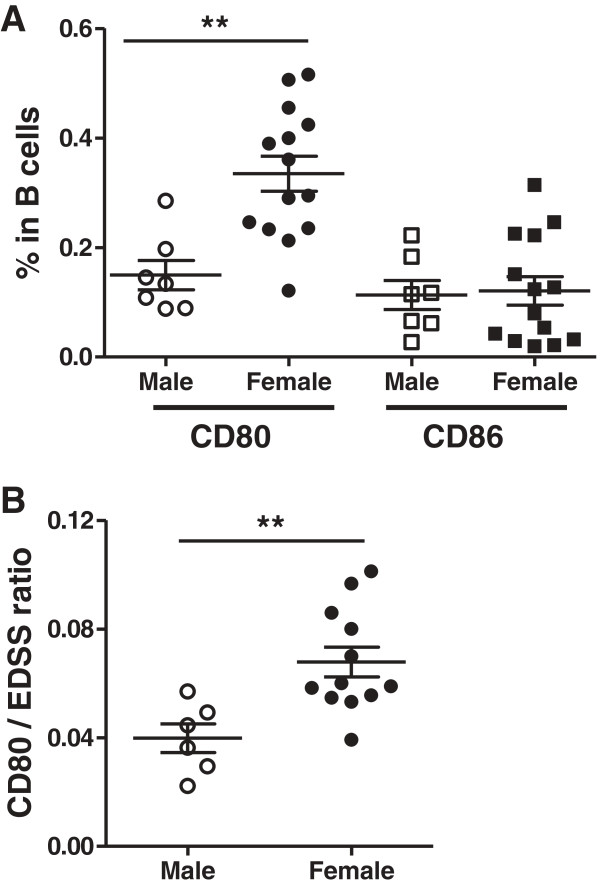
Gender-biased expression of CD80 but not CD86 in B cells of HAM/TSP patients. (A) Expression of CD80 but not CD86 in B cells is increased in female (n = 14) versus male (n = 7) patients (**p = 0.0013, unpaired t test). (B) B cell CD80 expression corrected for disease severity (EDSS) is significantly higher in female (n = 12) versus male (n = 6) HAM/TSP patients. (**p = 0.0054, unpaired t test).